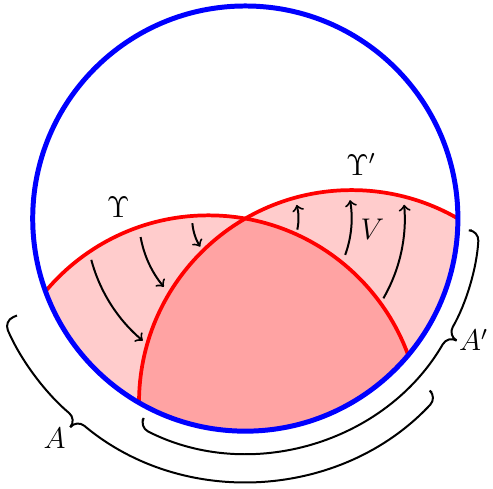
Figure 11. A deformation of the boundary subregion A ! A 0 leads to a corresponding deformation of the HRT surface (cid:7) ! (cid:7) 0 , generated by a bulk vector (cid:12)eld V . Di(cid:11)eomorphism invariance makes it easy to compute the bulk (cid:12)elds corresponding